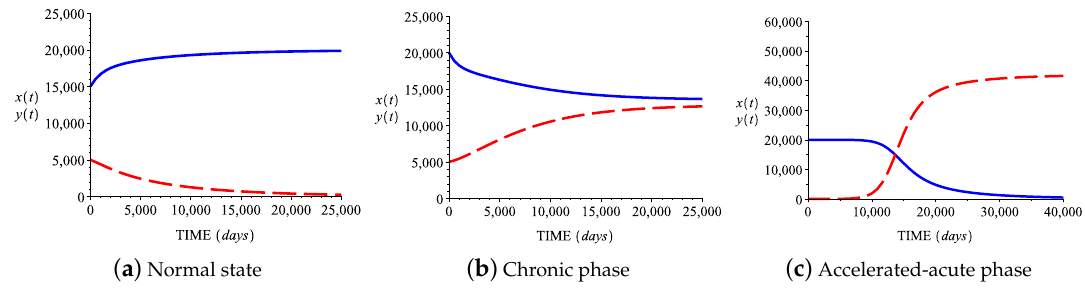
Figure 5. Behavior of the normal and abnormal (leukemic) stem cell populations in Case III. Initial conditions: ( a ) x ( 0 ) = 1.5 × 10 4 , y ( 0 ) = 5 × 10 3 ; ( b ) x ( 0 ) = 2 × 10 4 , y ( 0 ) = 5 × 10 3 ; ( c ) x ( 0 ) = 2 × 10 4 , y ( 0 ) =